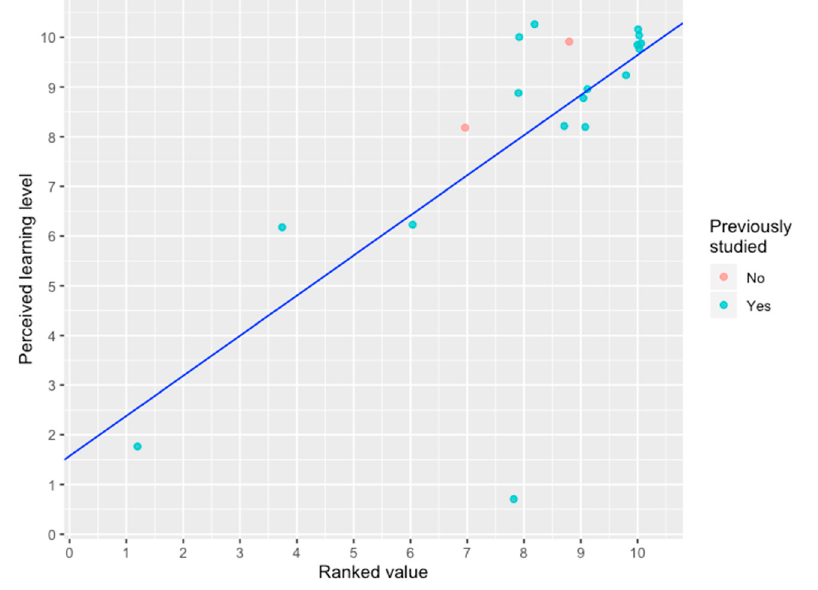
Figure 2. Scatter plot with “Ranked value” in x axis and “Perceived learning level” in y axis for each questionnaire. Jittering has been applied to the avoid data overplotting. Red dots indicate that the student did not study programming before, while blue dots indicate the student had previously studied programming. Furthermore, the blue line corresponding to the least square linear regression has been added for illustrative